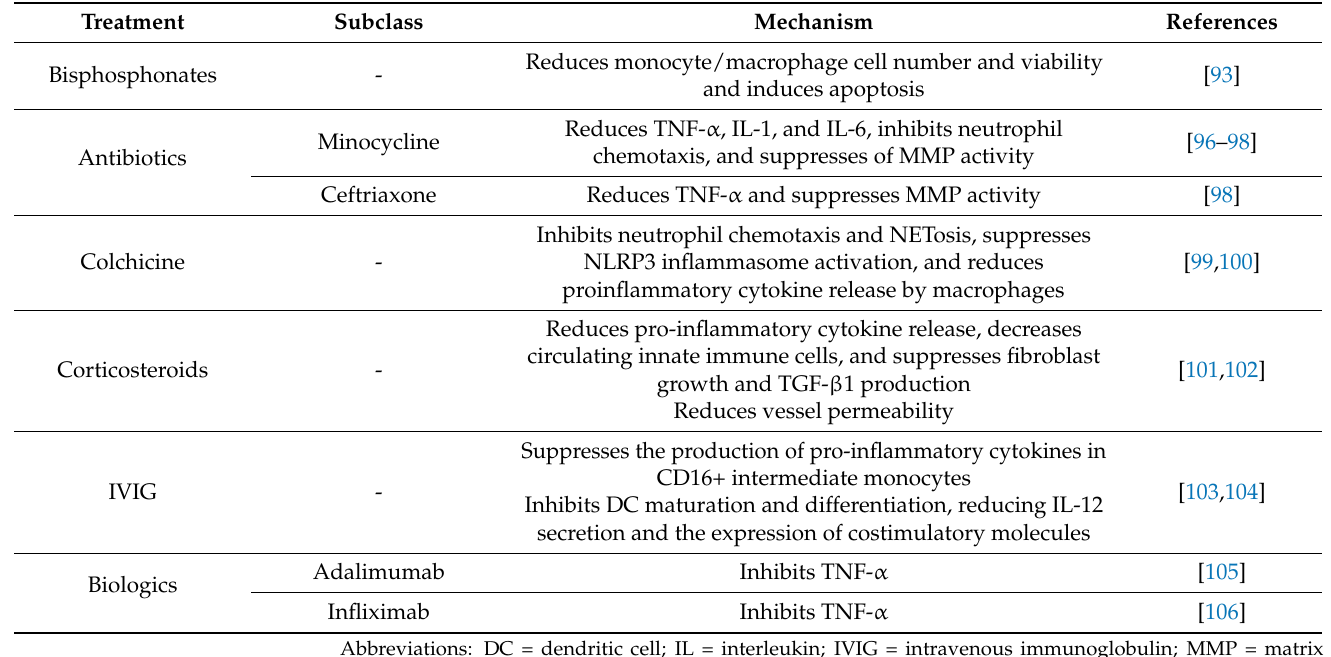
Table 2. Treatments for calcinosis cutis associated with the modulation of innate